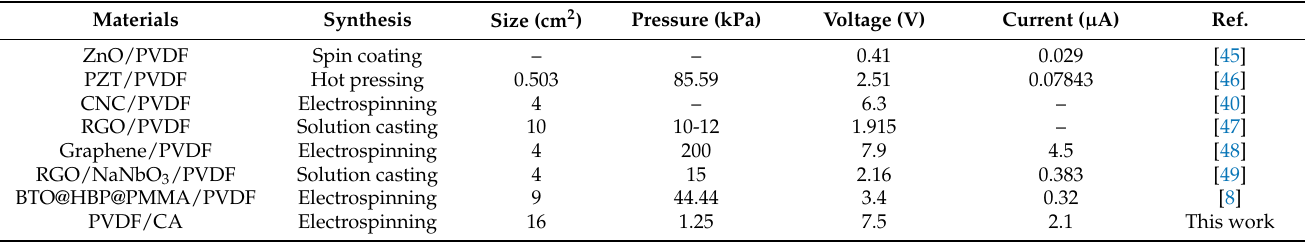
Figure 7. Output voltages and currents of PVDF/CA EFM-based PENGs with a membrane area of 4 × 4 cm 2 ( a ) under 1 N, and ( b ) under 2 N; ( c ) output voltages and currents of PVDF/CA EFM-based PENGs with a membrane area of 8 × 8 cm 2 under 1 N; trend diagrams of maximum output voltages and currents of PVDF/CA EFM-based PENGs ( d ) under 1 N and 2 N, and ( e ) and with membrane areas of 4 × 4 cm 2 and 8 × 8 cm 2 . Comparison of the performance of PVDF-based piezoelectric nanogenerators for different